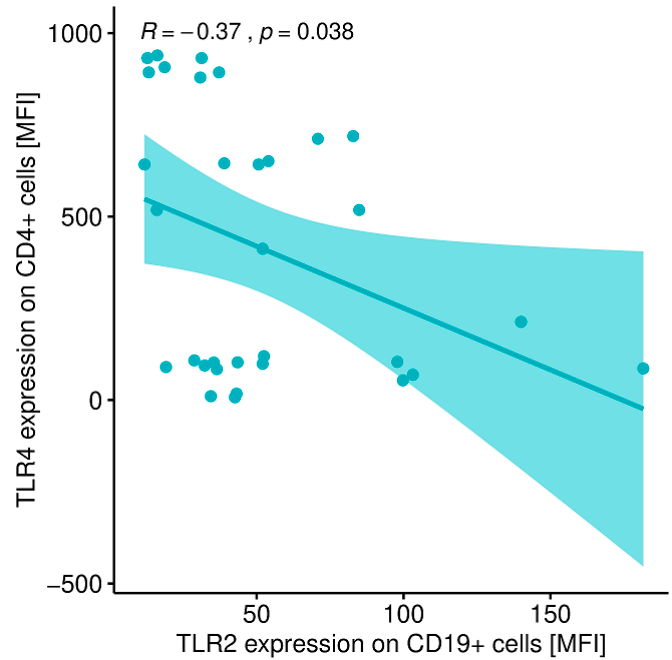
Figure 13. Correlation between the expression level of TLR-2 on CD19 + B lymphocytes (MFI) and the expression level of TLR-4 on CD4 + T lymphocytes (MFI) in patients with GD after obtaining euthyroidism. MFI, mean fluorescence intensity.